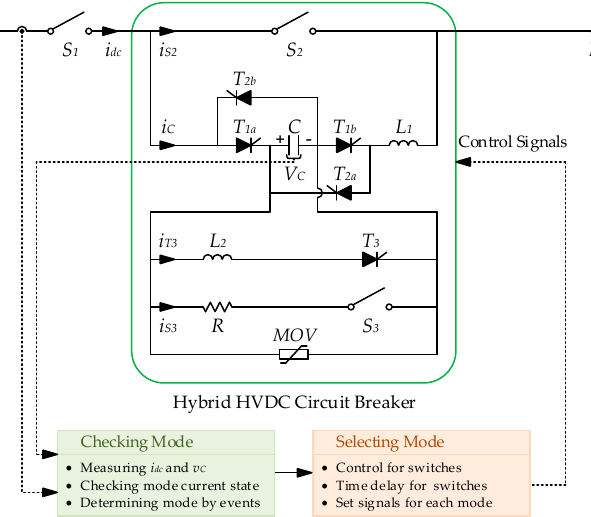
Figure 5. Operation mode of proposed HCB topology.